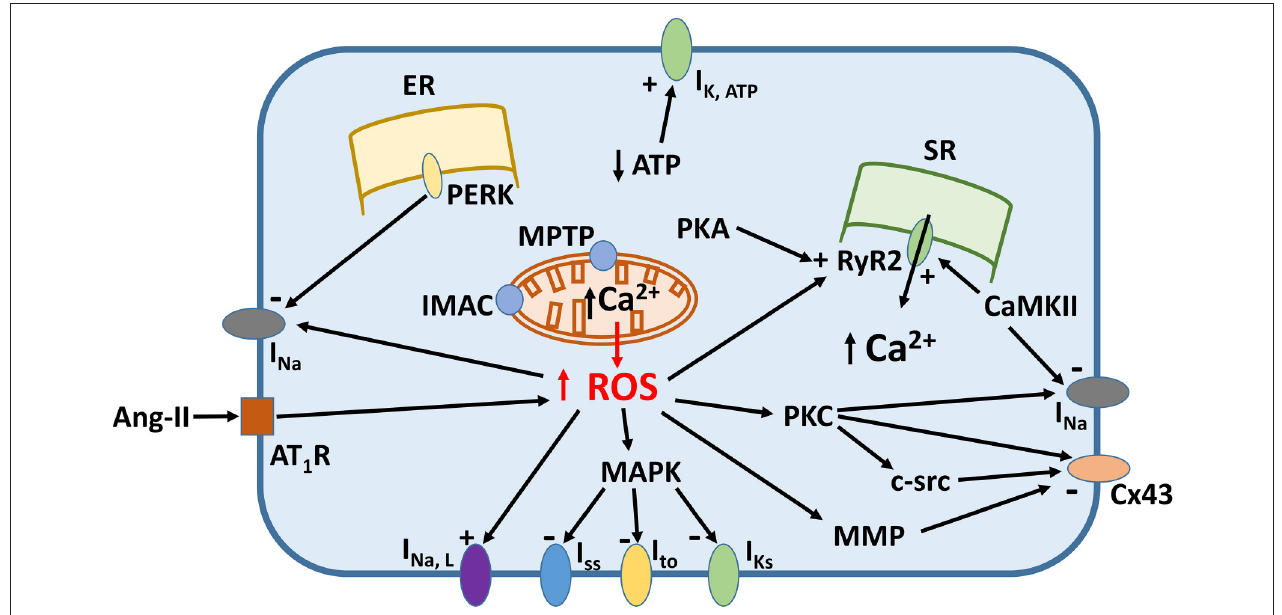
FIGURE 1 | Signaling mechanisms linking increased reactive oxygen species (ROS) production and ion channel